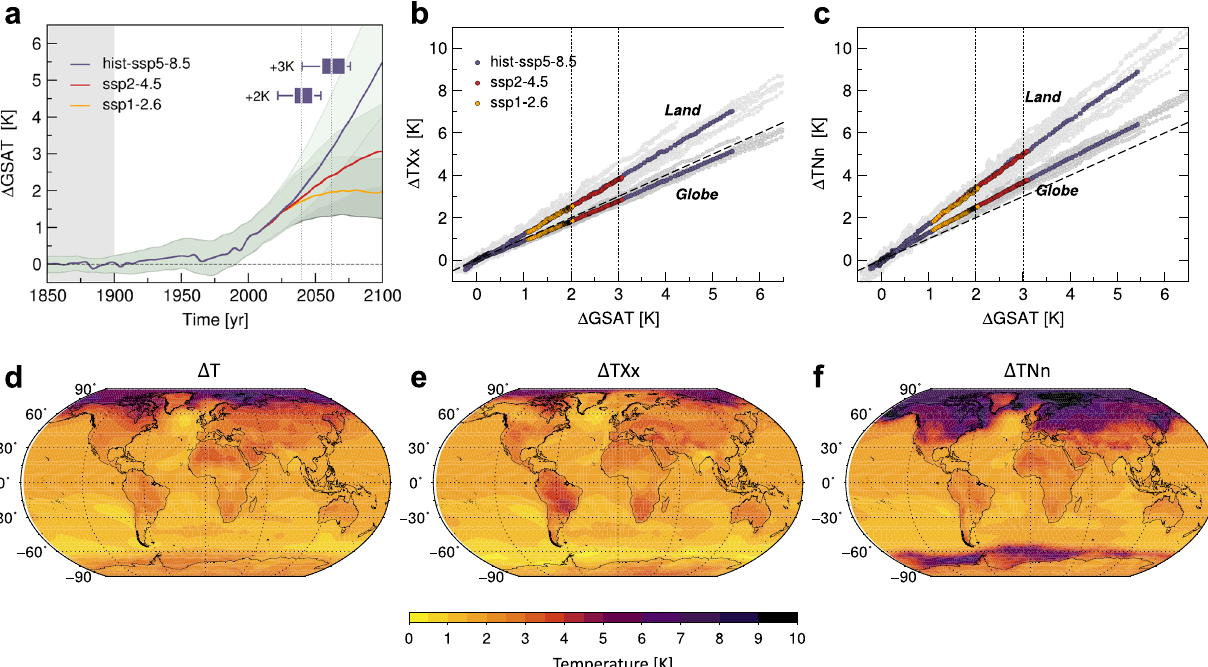
Fig. 1 | Global changes in mean temperatures and the extremes. a Changes in global-mean surface air temperature (GSAT)relative to early industrial times (gray shadedbackground),onthebasisof20modelsimulations(SupplementaryTable1) forced by alternative Shared Socioeconomic Pathways, namely SSP1-2.6, SSP2-4.5 and SSP5-8.5. Shaded bands denote the total spread in model projections, solid lines their multimodel mean. Box plots summarize the projected timings for GSAT toreach+2Kand+3KabovetheearlyindustrialmeanunderSSP5-8.5.Theyaccount